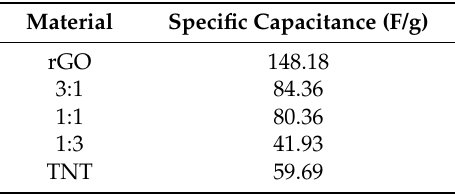
Table 2. Specific capacitance of rGO/TiO 2 composites at 5 mV/s.